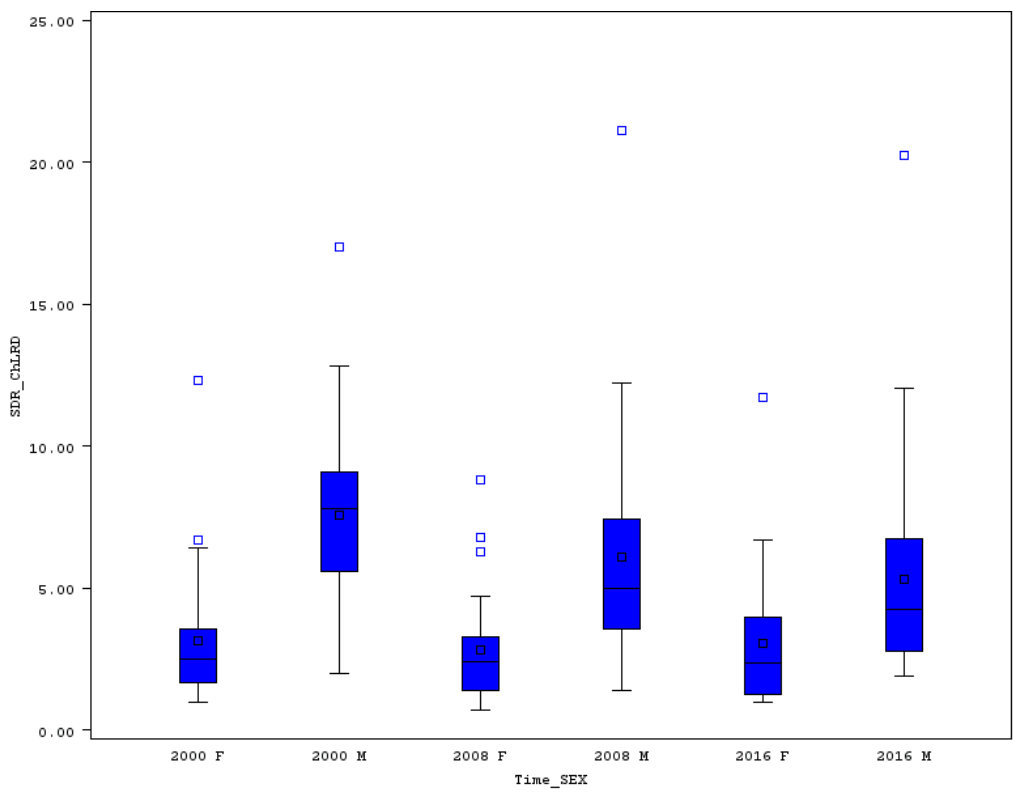
Figure 8. Boxplot of premature SDR for chronic lower respiratory diseases in EU countries for males and females in selected years. Source: Own calculations based on Eurostat database [20].